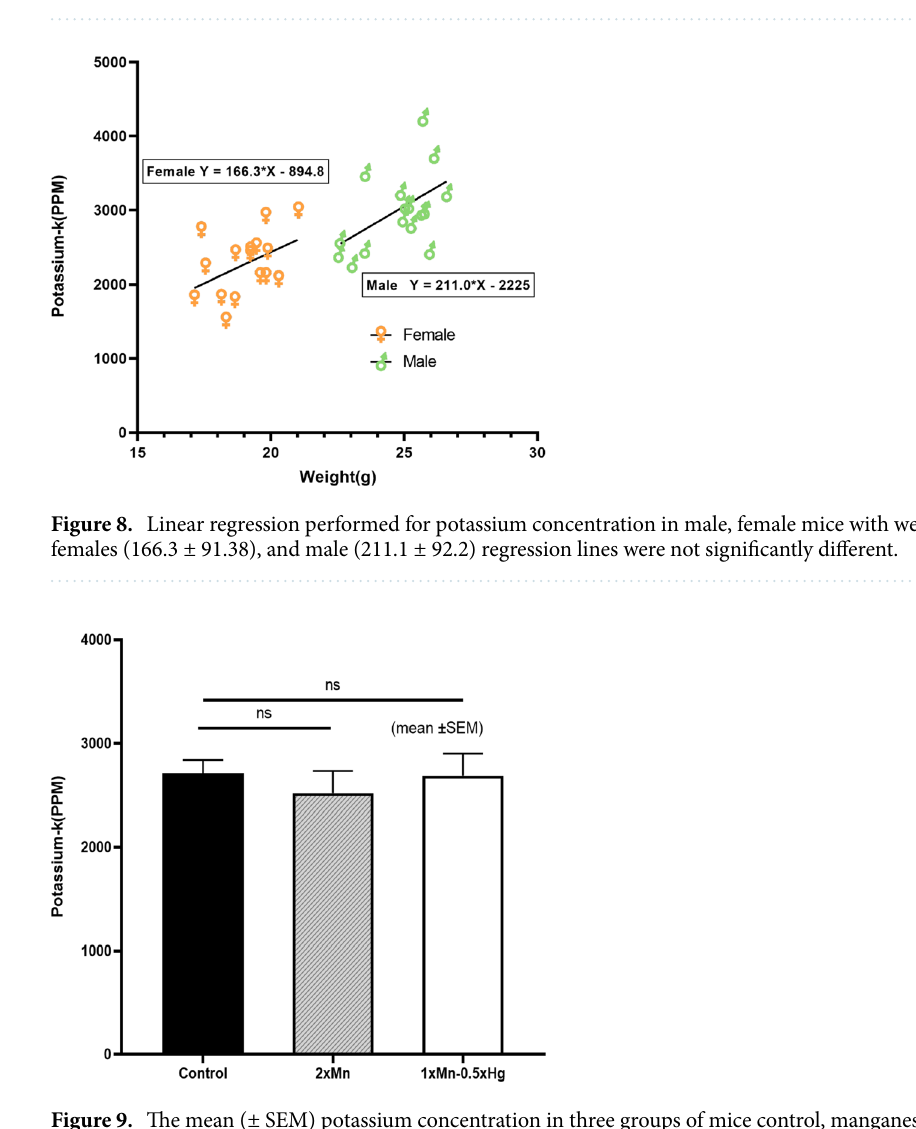
Figure 7. Potassium concentration (mean ± SEM) of male and female mouse samples after 10 min irradiation. Male n = 16; female n = 16. Unpaired two tailed t test (t = 4.35, df = 30); p = 0.0001, significant difference indicated by (**).